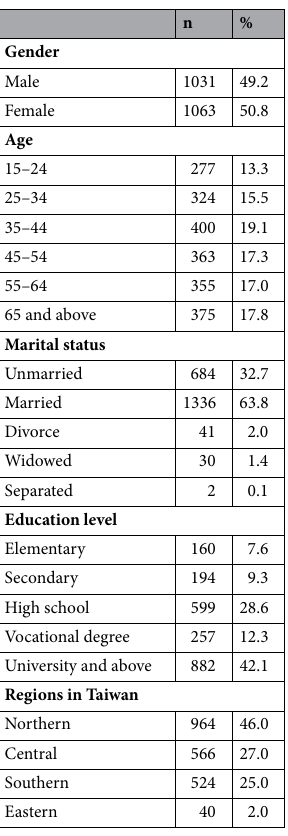
Table 1. Sociodemographic characteristics of the participants (N = 2094). All the above-mentioned data were weighted. The data of no response were excluded for